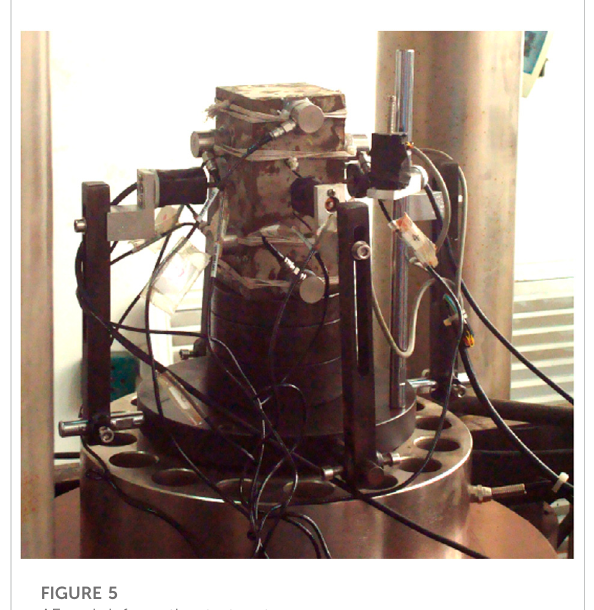
FIGURE 5 AE and deformation test system.